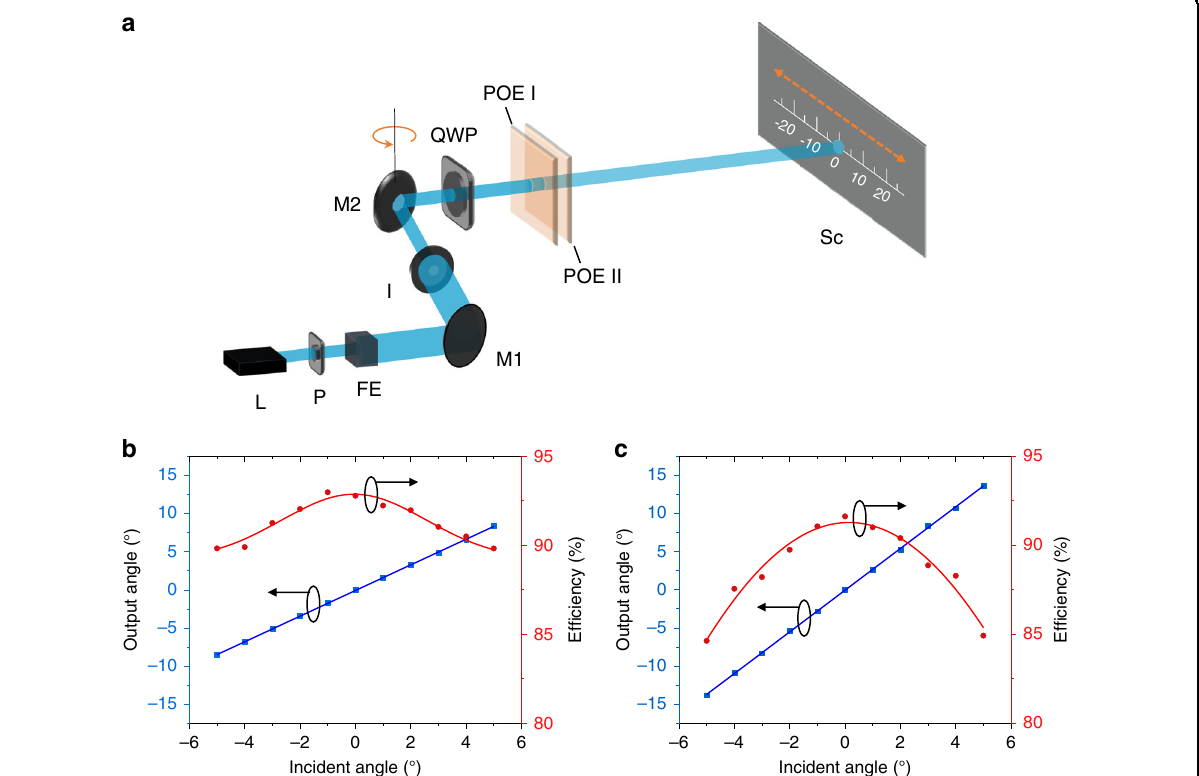
Fig. 3 Miniature planar telescope ef fi ciency and angle magni fi cation. a Schematic of the measurement setup. A 488-nm circularly polarized laser beam is incident on the planar telescope composed of two POEs. A mirror (M2) is fi xed on a rotational stage for the manipulation of incident angles. L laser, P polarizer, FE fi ltering and expansion, M1 mirror I, I iris, M2 mirror II, QWP quarter-wave plate, Sc screen. b Performance of module I which is composed of an f /5.5 POE I and an f /3.3 POE II. c Performance of module II which is composed of an f /5.5 POE I and an f /2 POE II. The measured data are presented by symbols and the solid lines are visual guides. The ovals and arrows highlight the y axis to which the data set corresponds. See the “ Materials and methods ” section for measurement